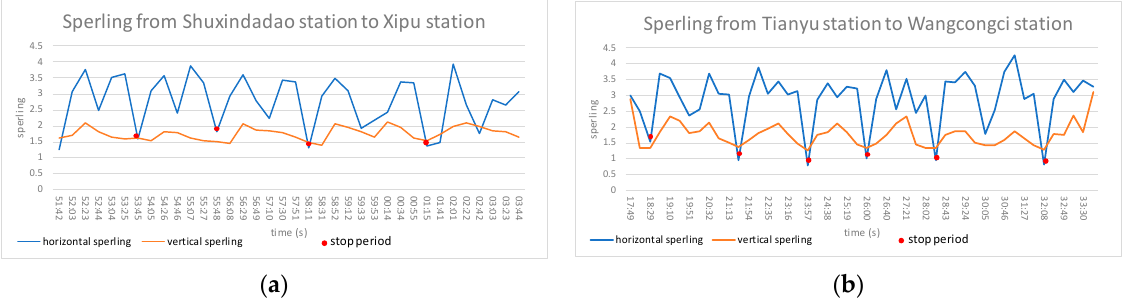
Figure 10. Three-way acceleration: ( a ) three-axis acceleration from Shuxin Avenue station to Xipu station; ( b ) three-axis acceleration from Tianyu station to Wangcongci station. Horizontal and vertical Sperling indicators corresponding to the two states are shown in Figure 11, where the value of the vertical Sperling indicator fluctuated between 1.5 and 2, and the value of the horizontal Sperling index fluctuated around 3 (the value was around 3.5 during subway operation and around 1.5 during the stops). According to the Sperling rating table of locomotives and rolling stock in China, during the whole measurement process, for the horizontal Sperling index value, the subway operation stage is scored as “pass” or “good”, due to the more obvious vibration in individual periods, and in the stop phase, the score is “excellent”. For the vertical Sperling index value, the whole process is relatively stable, and the score is “excellent”. The measured data of the two states are roughly consistent with actual human experience.